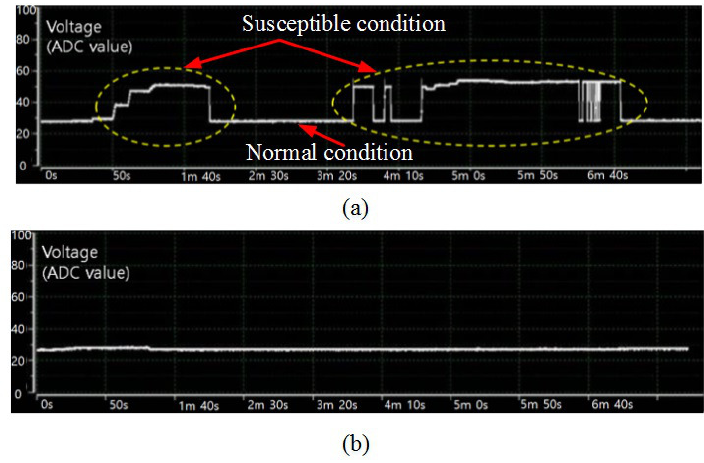
Figure 17. Performed NFIT RI results for a specific automotive industry electronic DUT with E-field probe (see Figure 16b): ( a ) Induced voltage in PCB with near-field E-probe driven by 12 W input power (error debugging); and ( b ) Induced voltage in PCB after circuit modification (error rectification) with near-field E-probe is driven by same 12 W input power.